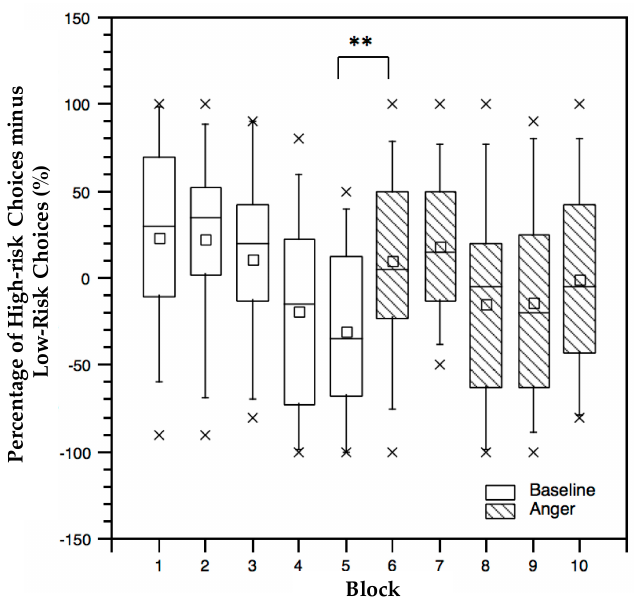
Figure 3. Percentage of high-risk choices minus low-risk choices across blocks. * p < 0.05, ** p < 0.01.